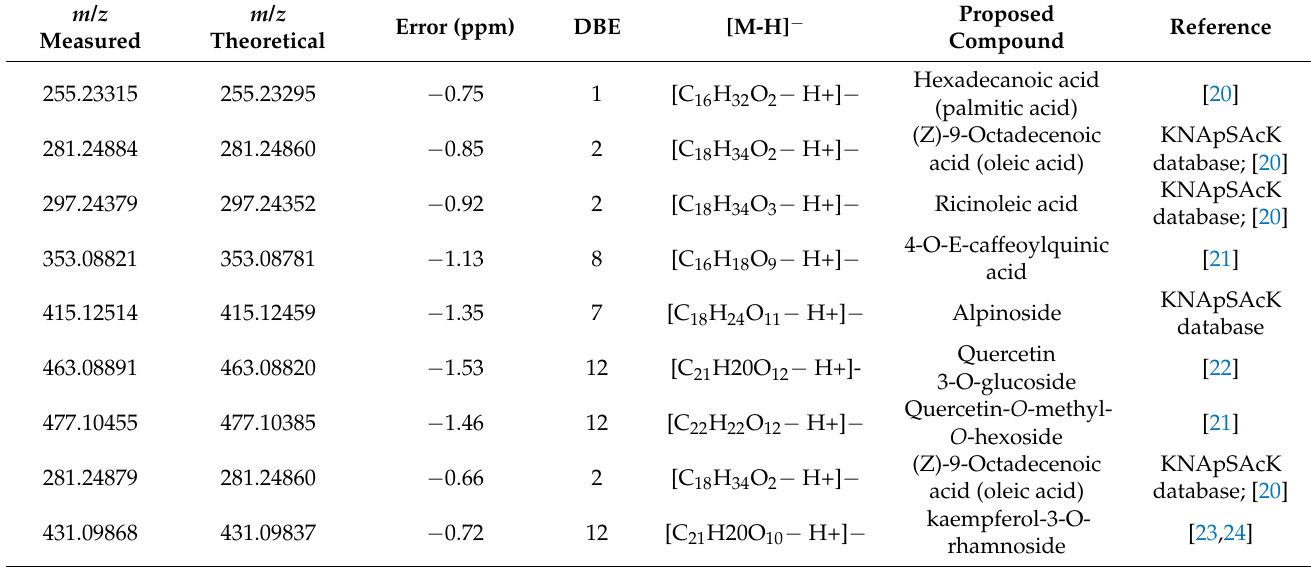
Table 4. Proposed structures by Electrospray Ionization Fourier Transform Ion Cyclotron Resonance Mass Spectrometry (ESI (-) FT-ICR MS) for the identified molecules of chloroform partition of A. crassiflora .